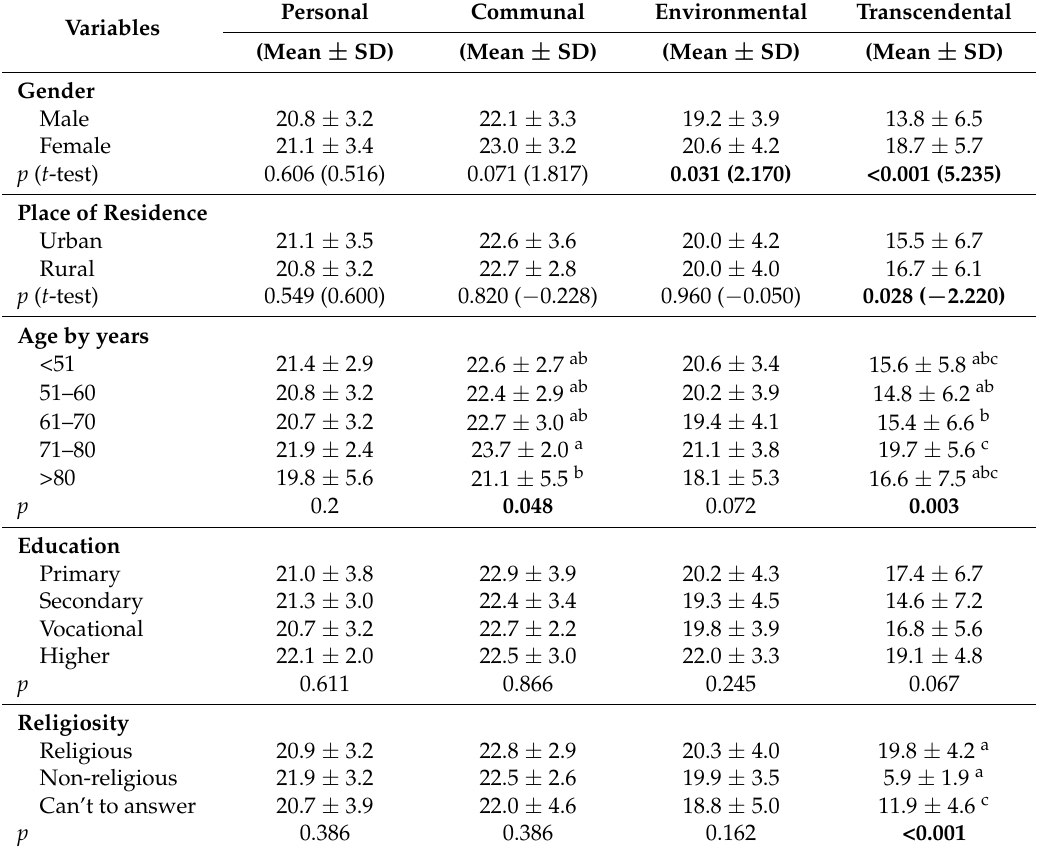
Table 5. Comparison of SHALOM–Ideals between sociodemographic characteristics (N = 171).